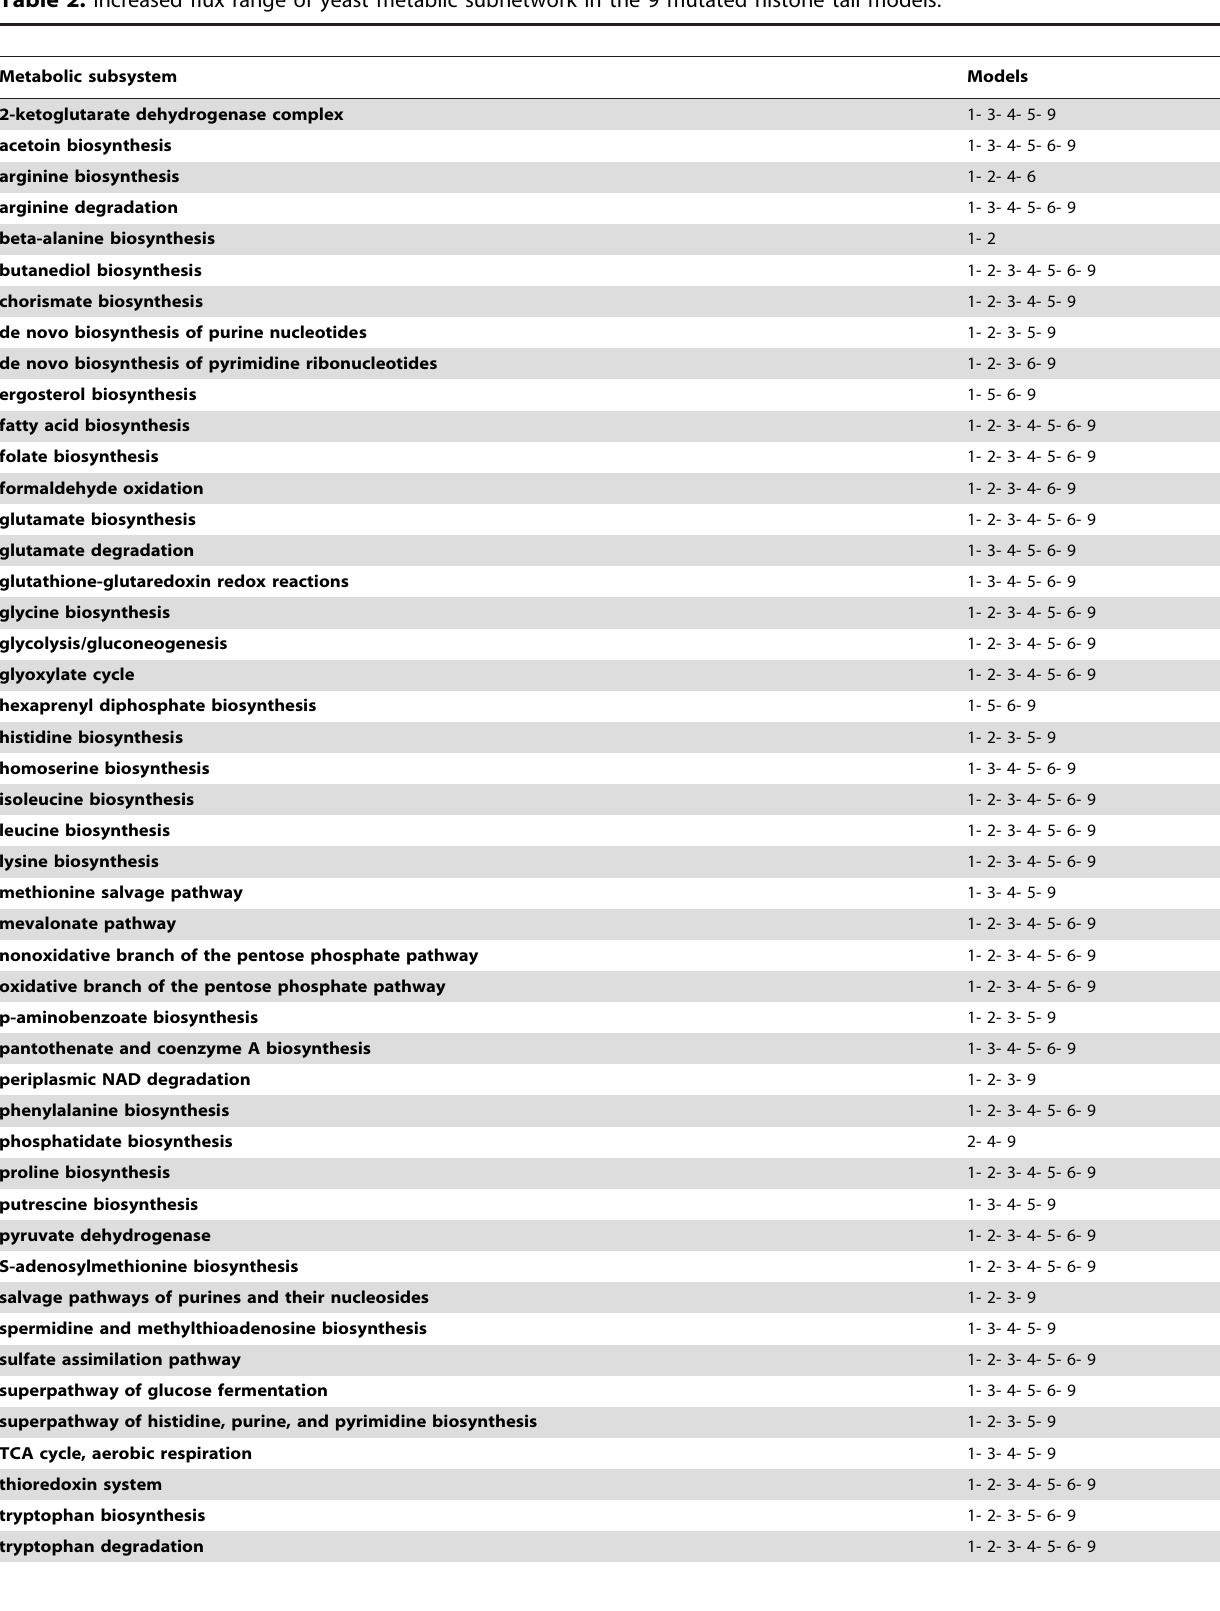
Table 2. Increased flux range of yeast metablic subnetwork in the 9 mutated histone tail